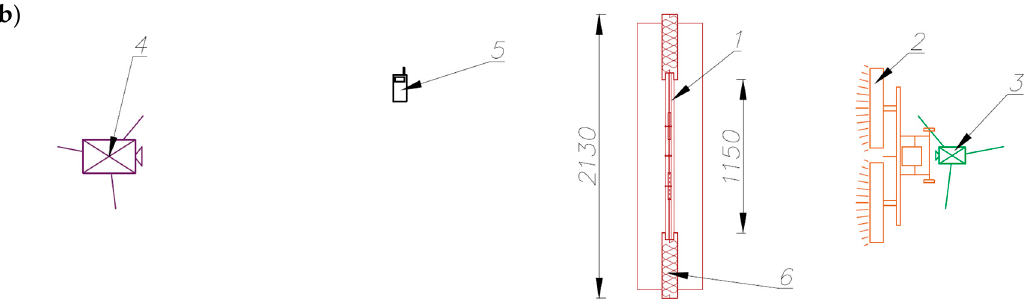
Figure 2. Schematic of test stand (given units in mm): ( a ) side view and ( b ) top view. Designations in the figure: 1—tested partition model, 2—infrared radiator, 3—thermal imaging camera Optris PI400, 4—thermal imaging camera Flir P65, 5—air temperature and relative humidity sensor, 6—Styrofoam band.